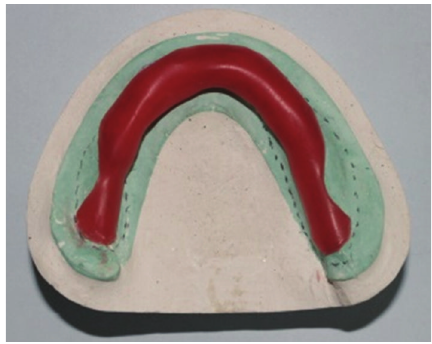
Figure 6: Clear acrylic custom “open” tray.